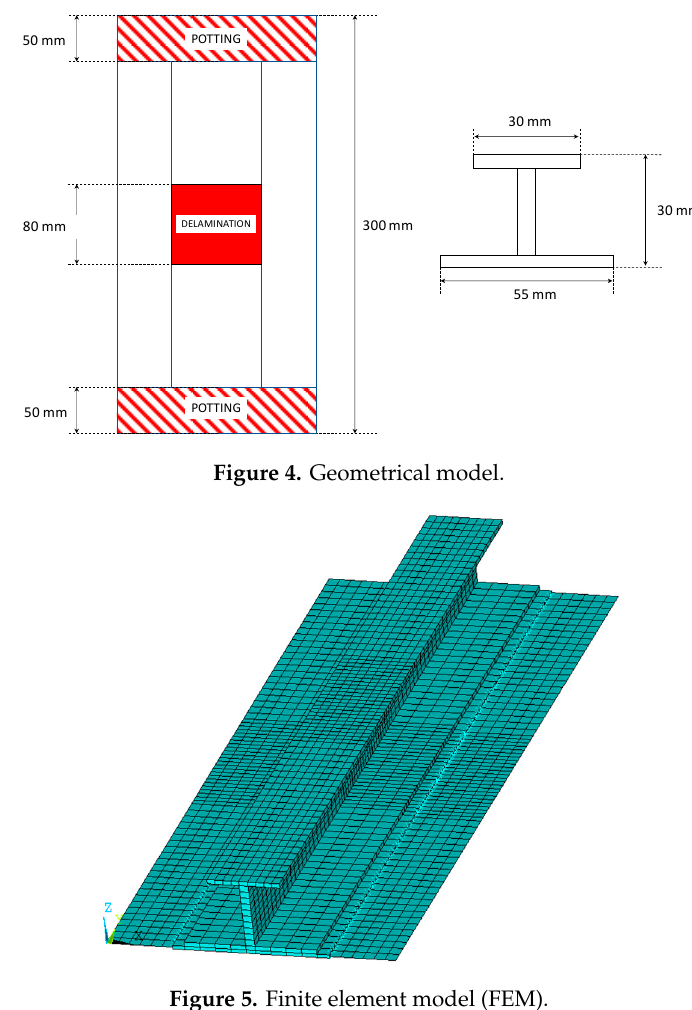
Figure 5. Finite element model (FEM).